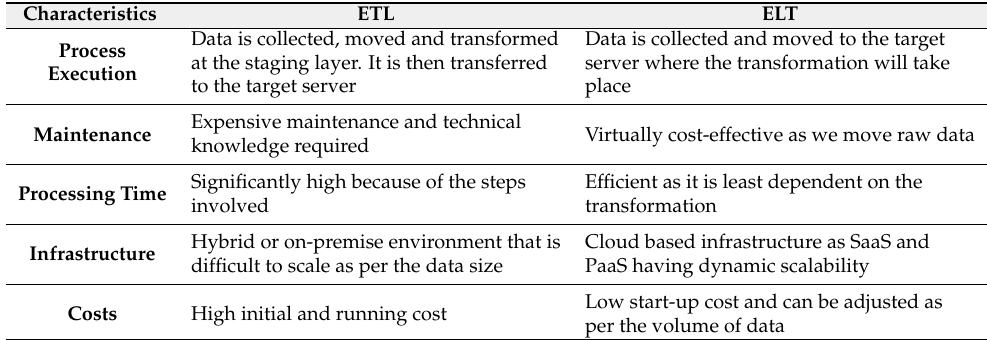
Table 1. Summary of the characteristics of ETL and ELT for integration with smart